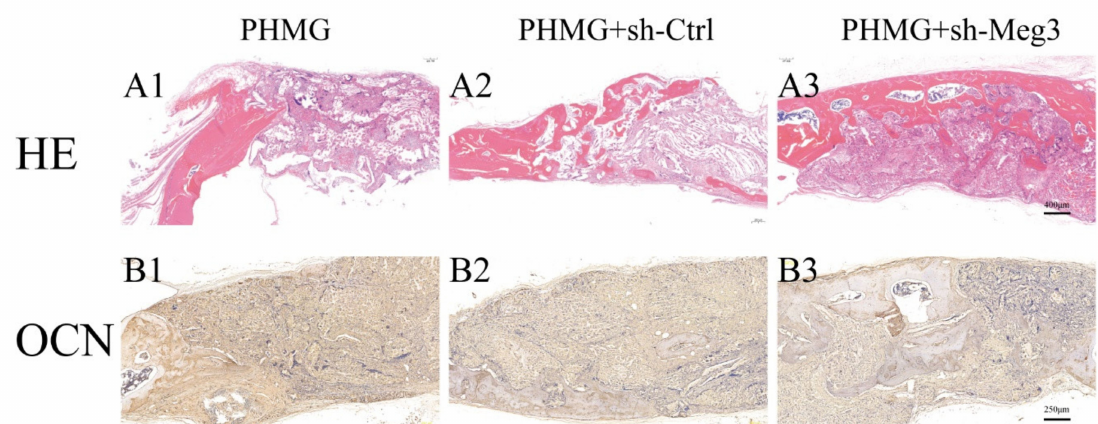
Figure 6. IHC analysis and OCN staining were used to detect osteogenesis of each group. ( A1 – A3 ) HE staining analysis, the red color represents new bone formation; ( B1 – B3 ) OCN staining analysis, the brown color represents positive staining of OCN. Bars = 400 µ m in up panel and Bars = 250 µ m in down